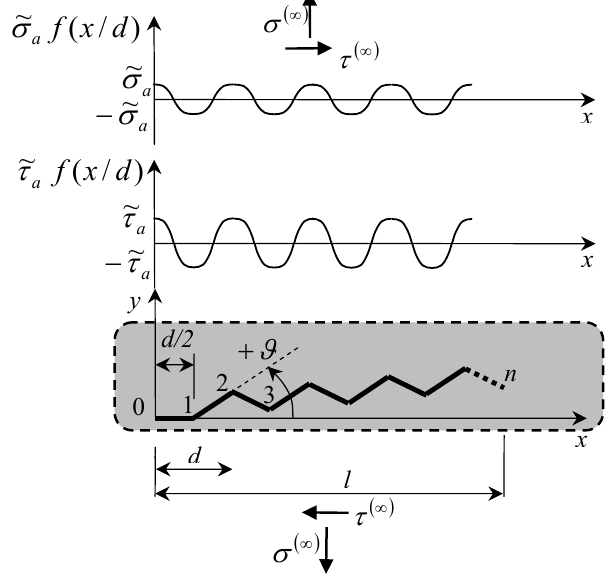
Figure 2: Mixed-mode crack growth in the self-balanced microstress